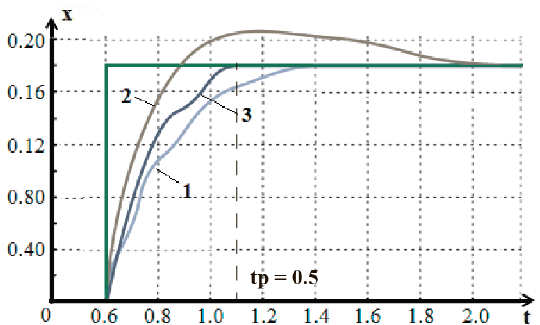
Figure 7. Diagram of a hybrid control algorithm for a carriage of rodless pneumatic actuator based on fuzzy logic and a PID controller